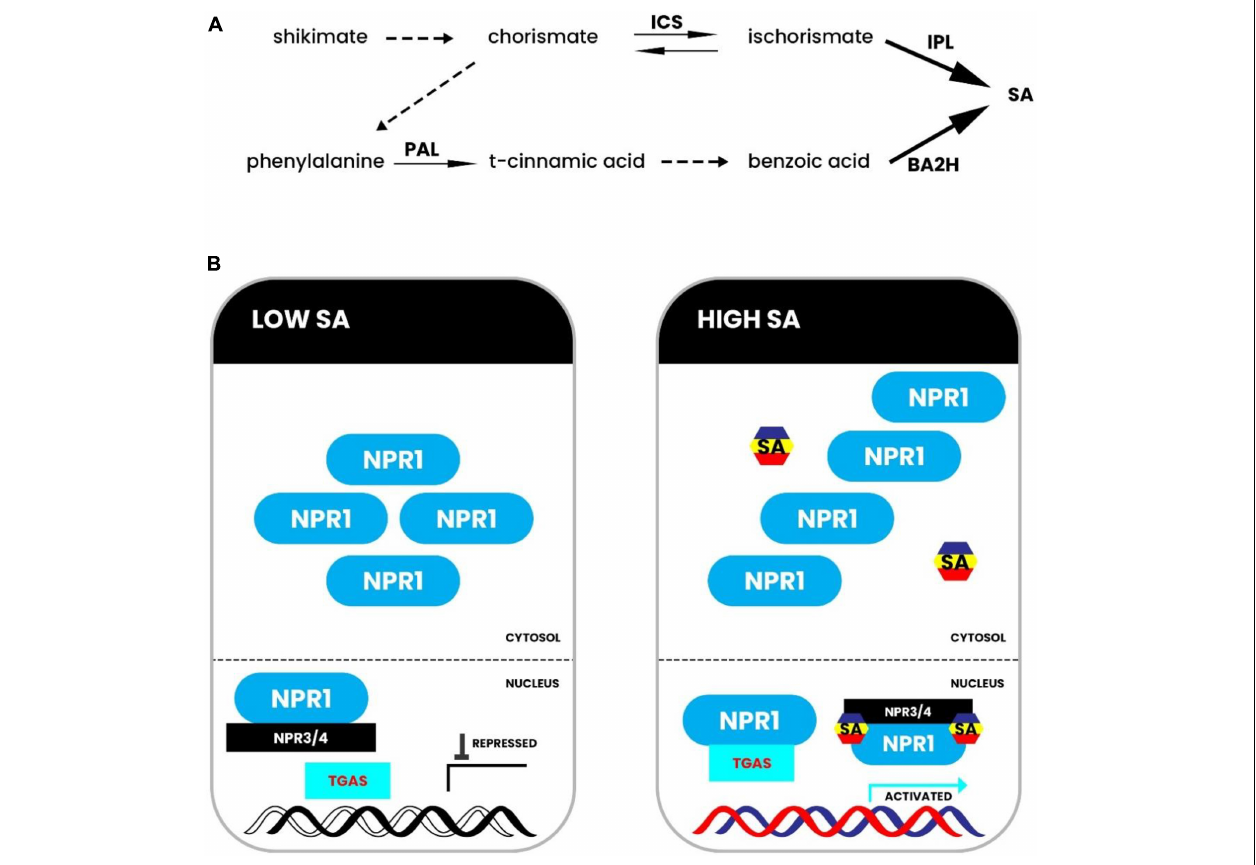
FIGURE 4 | Biosynthesis and signaling of salicylic acid. (A) In Arabidopsis, a model for salicylic acid (SA) production has been proposed. Genetic investigations showed the isochorismate pathway in the upper panel. Biochemical research showed the phenylpropanoid pathway in the lower panel. (B) NPR1 forms an oligomer in the cytosol in cells with low SA levels, and NPR3 and NPR4 bind leftover NPR1 in the nucleus to block NPR1 activity. NPR1 becomes monomeric and reaches the nucleus in cells with high SA levels, where SA binds to NPR3 and NPR4 to disrupt their transcriptional repression action. NPR1 interacts with TGAs in SA-responsive promoters, causing defensive responses to be activated. BA2H stands for benzoic acid 2-hydroxylase; ICS stands for isochorismate synthase; IPL stands for isochorismate pyruvate lyase; NPR stands for non-expresser of pathogenesis-related genes; PAL stands for phenylalanine ammonia lyase; SA stands for salicylic acid; TGA stands for TGACG-binding factor. Adapted from Li et al.